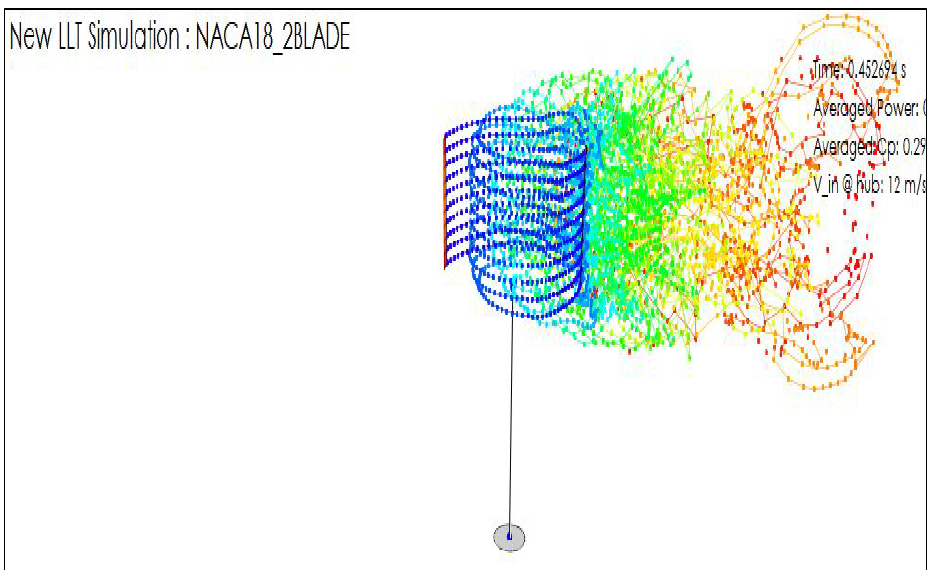
Figure 49. Two-bladed vortex simulation